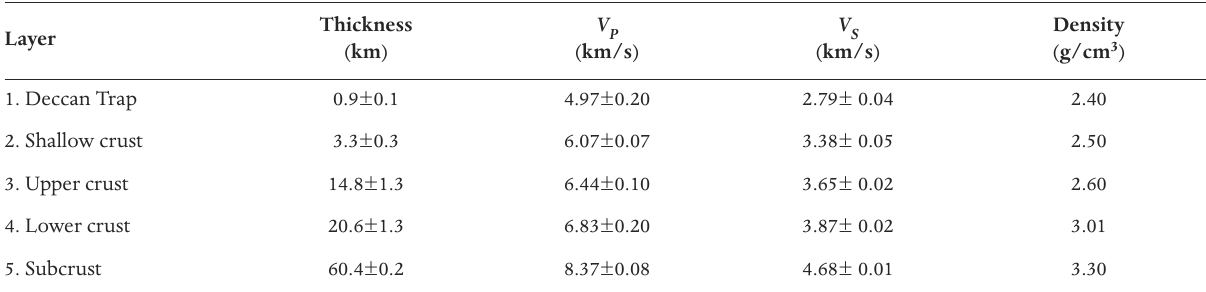
Table 4. Crustal and Subcrustal Structure for central DVP down to 100 km. Below 100 km the structure is same as that of IP11 [Bhattacharya 1981]. Thickness of crust = 39.6 ± 0.2 km. The value after ± shows corresponding standard